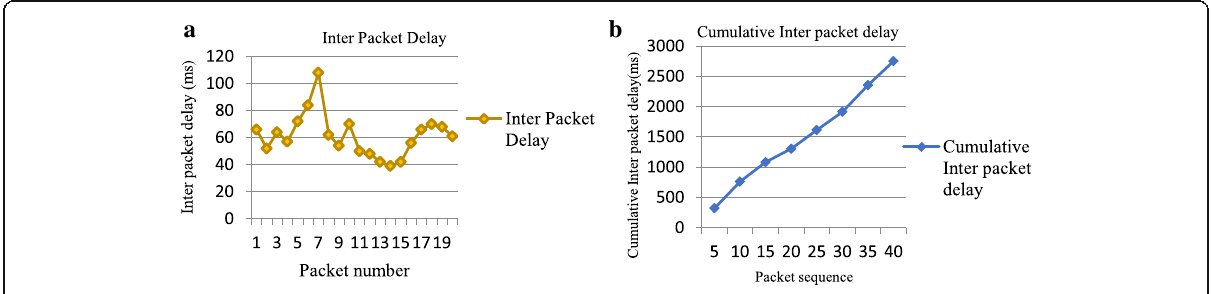
Fig. 9 Packet arrival delay. a The inter-packet delay. b The cumulative inter-packet